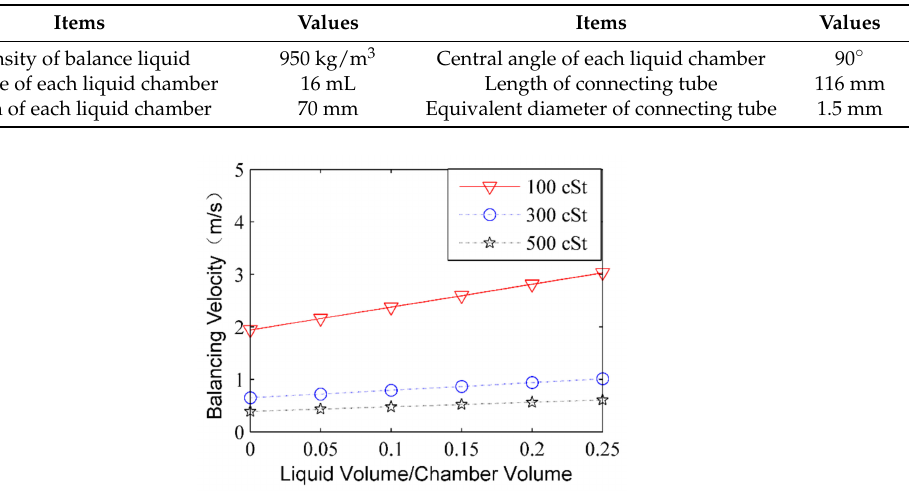
Table 1. Parameters of balance actuator.